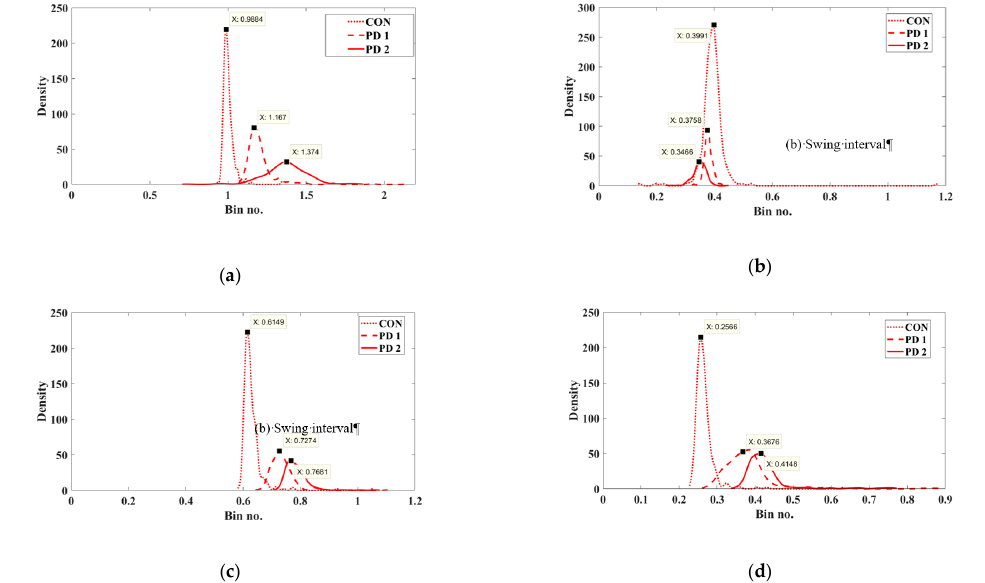
Figure 2. Histogram plot of subjects randomly selected from each group: ( a ) stride, ( b ) swing, ( c ) stance, and ( d ) double-support interval for CON, PD1, and PD2 subjects, respectively.